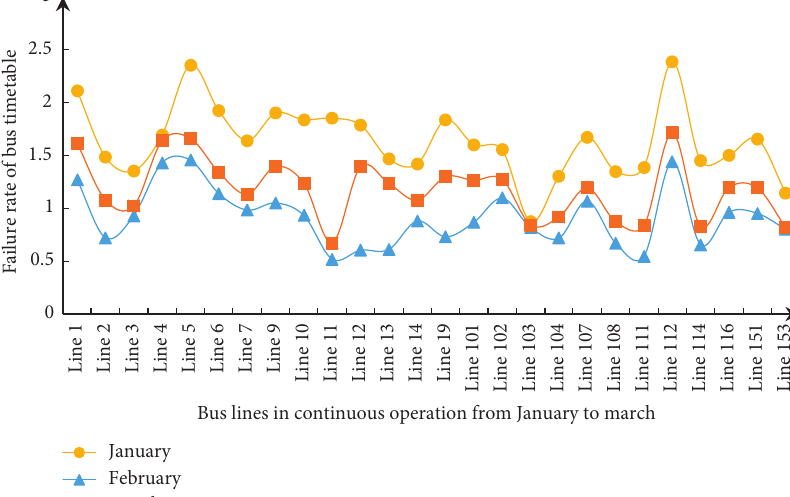
Bus lines in continuous operation from January to